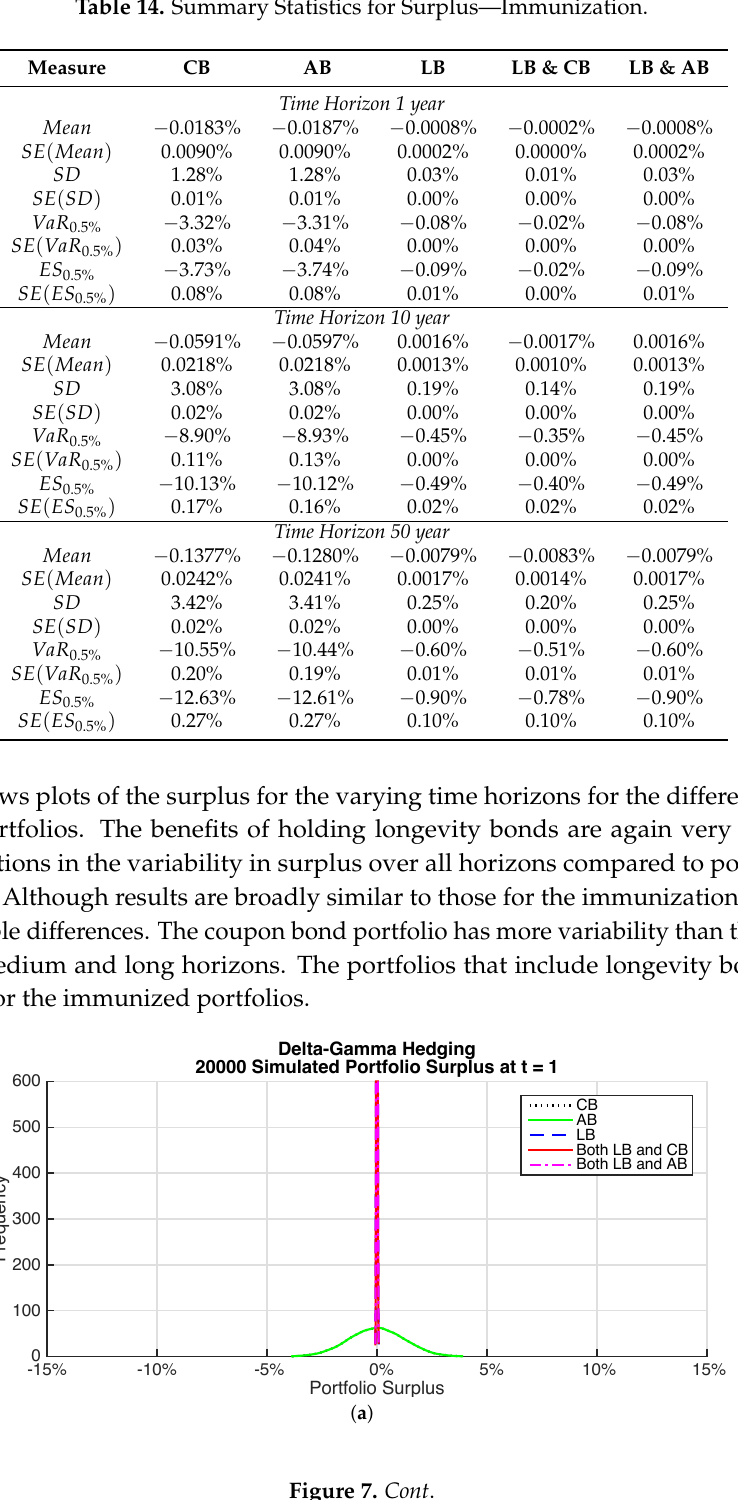
Table 14. Summary Statistics for